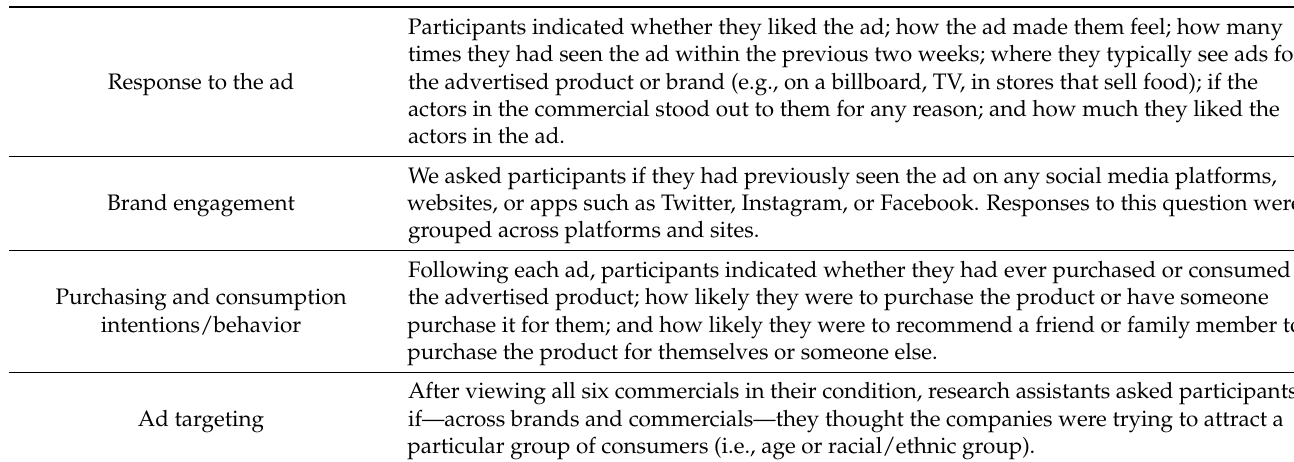
Table 2. Main questions used to facilitate discussions after participants watched TV commercials.